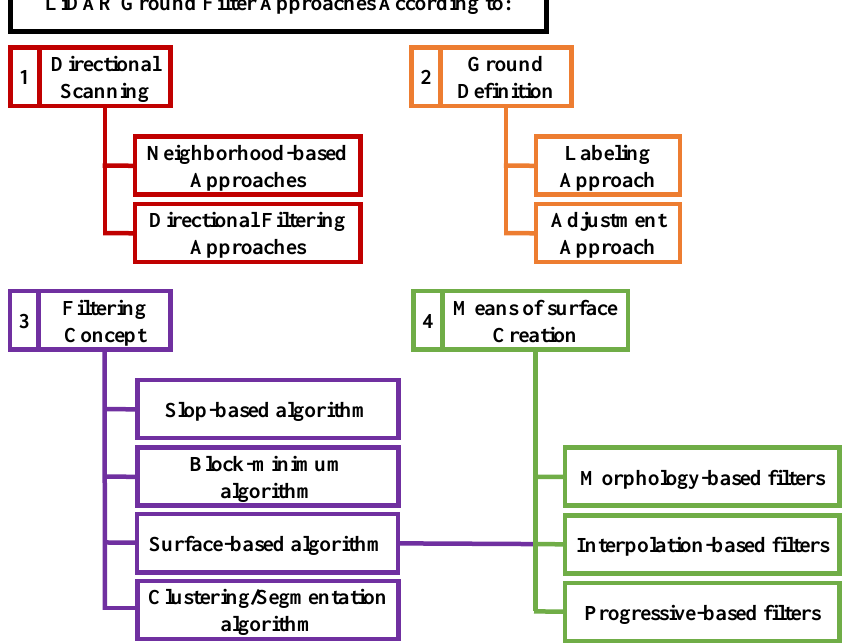
Figure 3. LiDAR (Light Detection and Ranging) ground filtering different